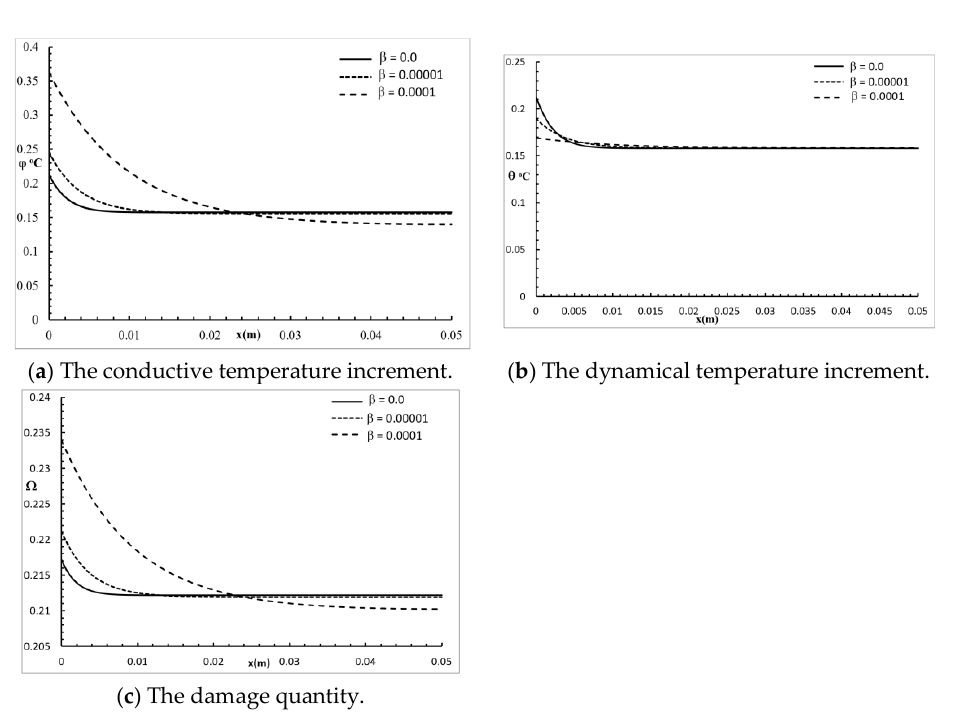
Figure 3. The studied functions at various positions for various values of the two-temperature Figure3. parameter.